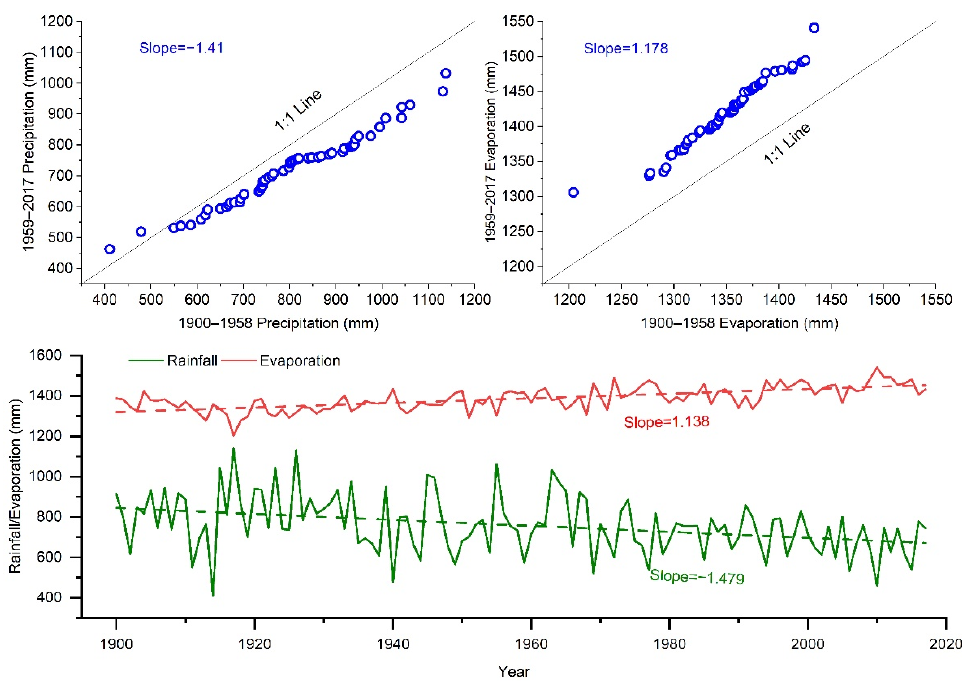
Figure 12. Changing trend in annual rainfall and annual evaporation from 1977 to 2017 in the Gnangara region. Gnangara